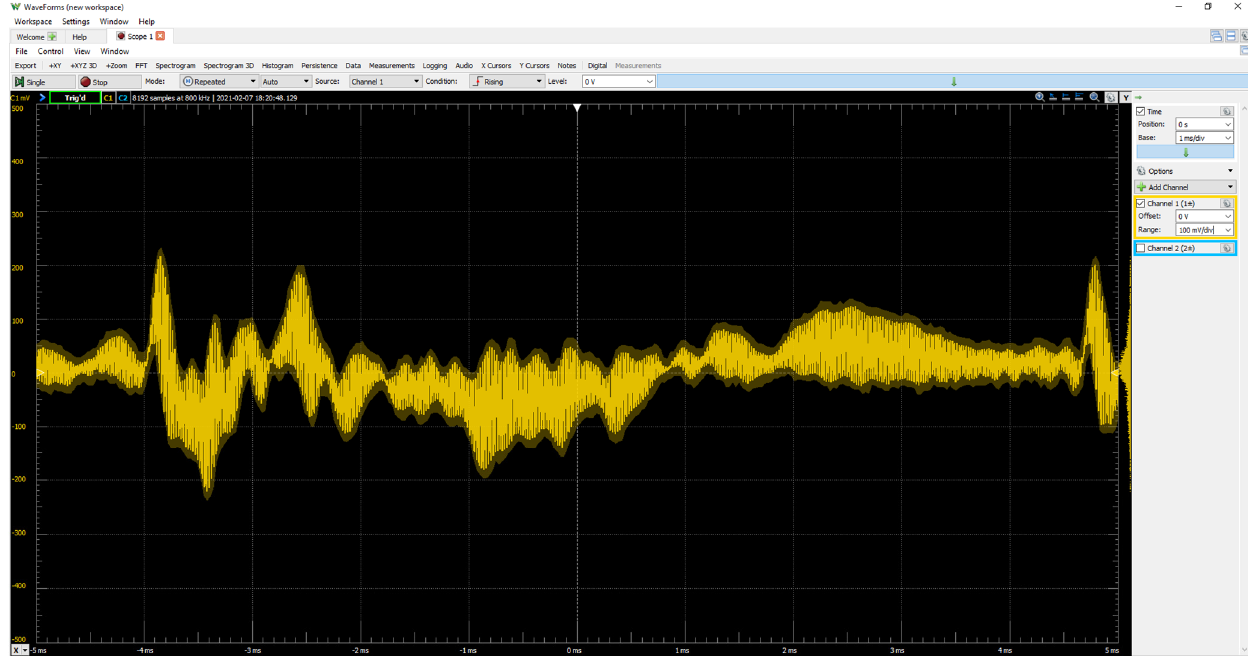
Figure 14. Actual output signal from the receiver in time domain.